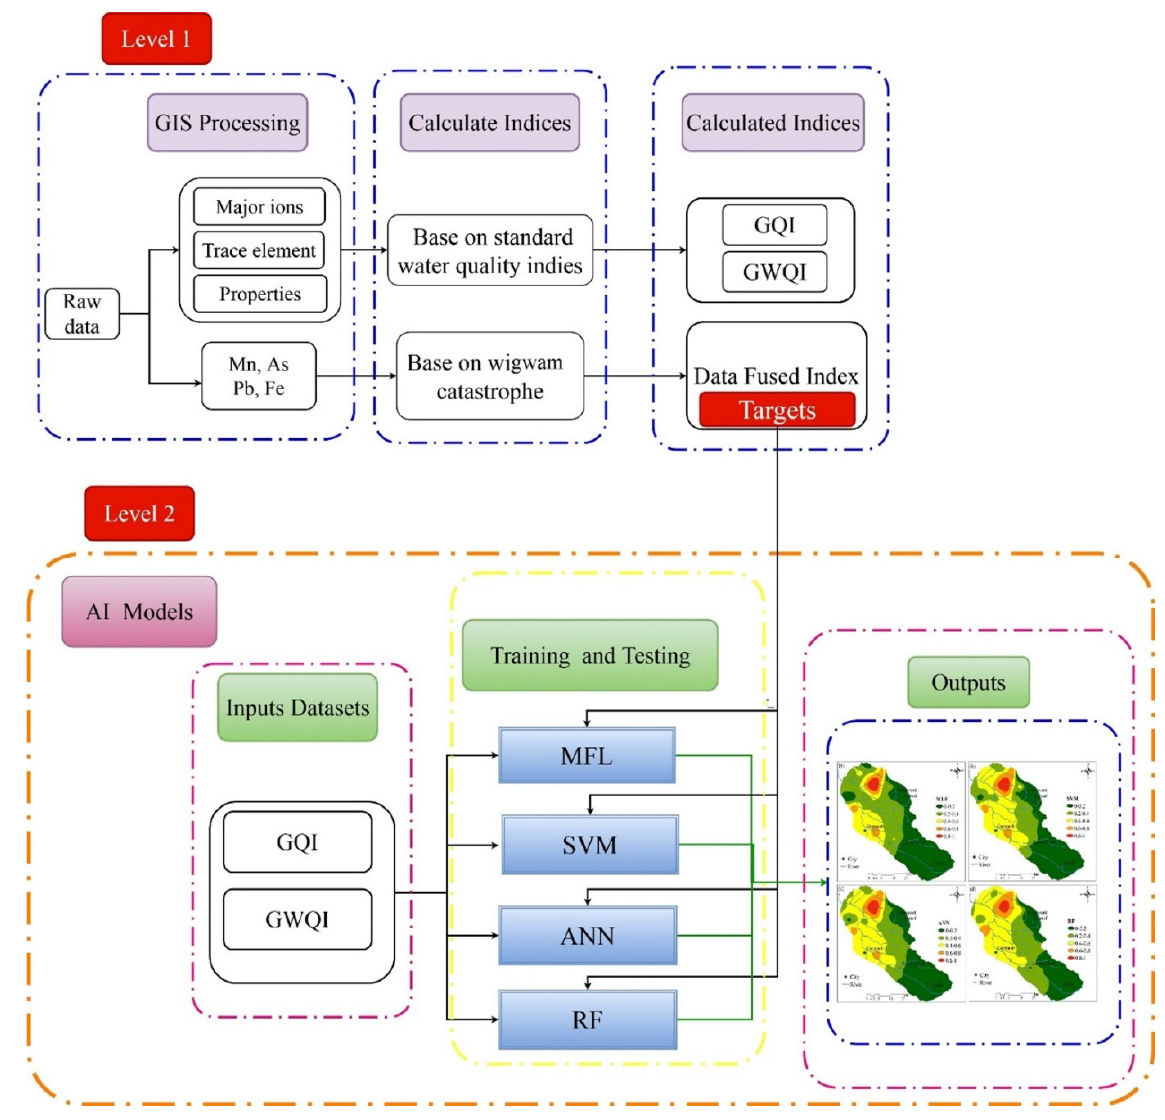
Figure 4. Flowchart of the developed methodology.